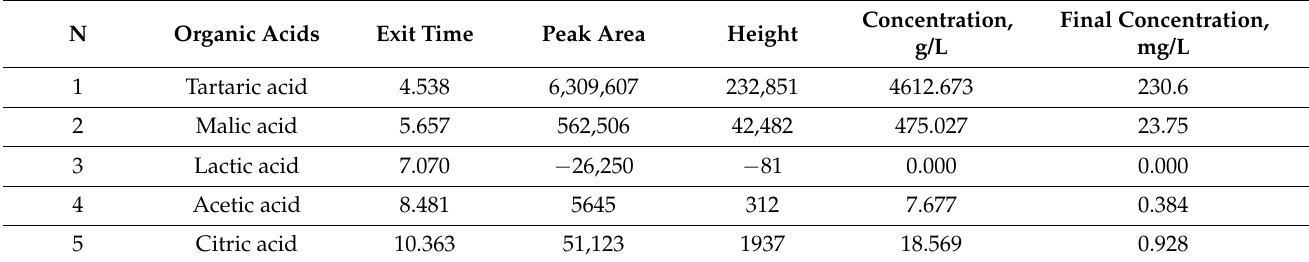
Table 5. Analysis of organic acids in culture liquid At. ferrooxidans ZnC by